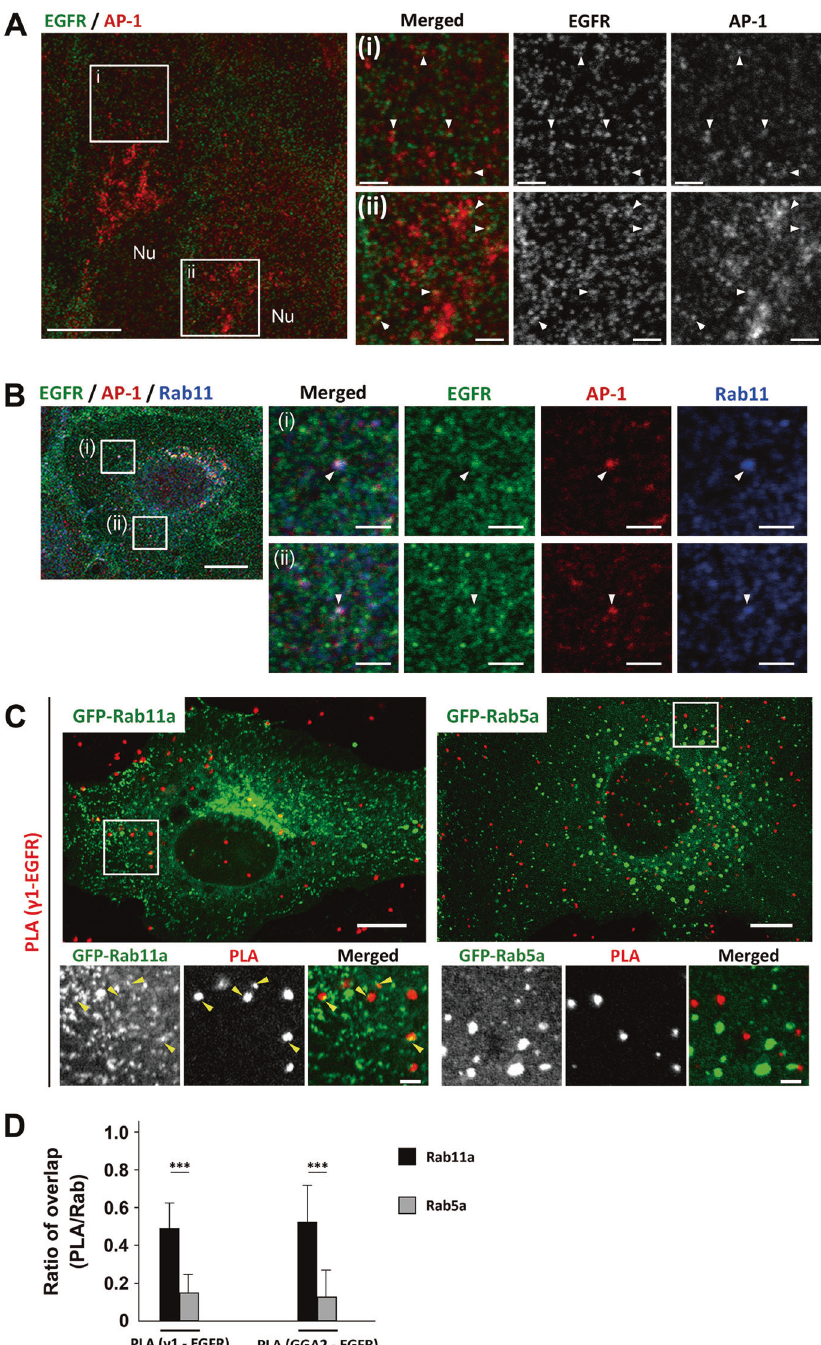
Fig. 4 AP-1 and GGA2 interact with EGFR at the recycling endosomes. A Double immuno fl uorescence microscopy of ARPE-19 cells immunostained with anti-EGFR (green) and anti- γ 1 (red) antibodies. Boxed regions (i) and (ii) are magni fi ed and shown in the right. Arrowheads indicate colocalization of both signals. Nu: nucleus, bars: 10 μ m (left) and 2 μ m (magni fi ed images). B Triple immuno fl uorescence microscopy of ARPE-19 cells immunostained with anti-EGFR (green), anti- γ 1 (red), and anti-Rab11 (blue) antibodies. Boxed regions (i) and (ii) are magni fi ed and shown in the right. Arrowheads indicate colocalization of three signals. Nu: nucleus, Bars: 10 μ m (left) and 2 μ m (magni fi ed images). C PLA of ARPE-19 cells transfected with GFP-Rab11a or GFP-Rab5a (green). Transfectants were processed for PLA with a combination of anti- γ 1-adaptin and anti-EGFR ( γ 1 – EGFR). In this experiment, cells with very low expressions of the GFP-fusion proteins were selected, and thus the laser beam power was set at 2 – 5-folds of conventional observations. Boxed regions are magni fi ed and shown below. Yellow arrowheads indicate the overlap of both signals. Bars: 10 μ m (top) and 2 μ m (bottom). D PLA signal that overlapped with GFP-Rab11a or GFP- Rab5a was quanti fi ed and plotted as the fraction of total PLA signal (mean ± SD; n = 35 [ γ 1-EGFR/Rab11a and GGA2/Rab5a], 34 [GGA2/ Rab11a], and 38 [ γ 1-EGFR/Rab5a]). Statistical differences were analyzed using Student ’ s t -test (*** P < 0.001). PLA for GGA2 – EGFR interaction is shown in Supplementary Fig.